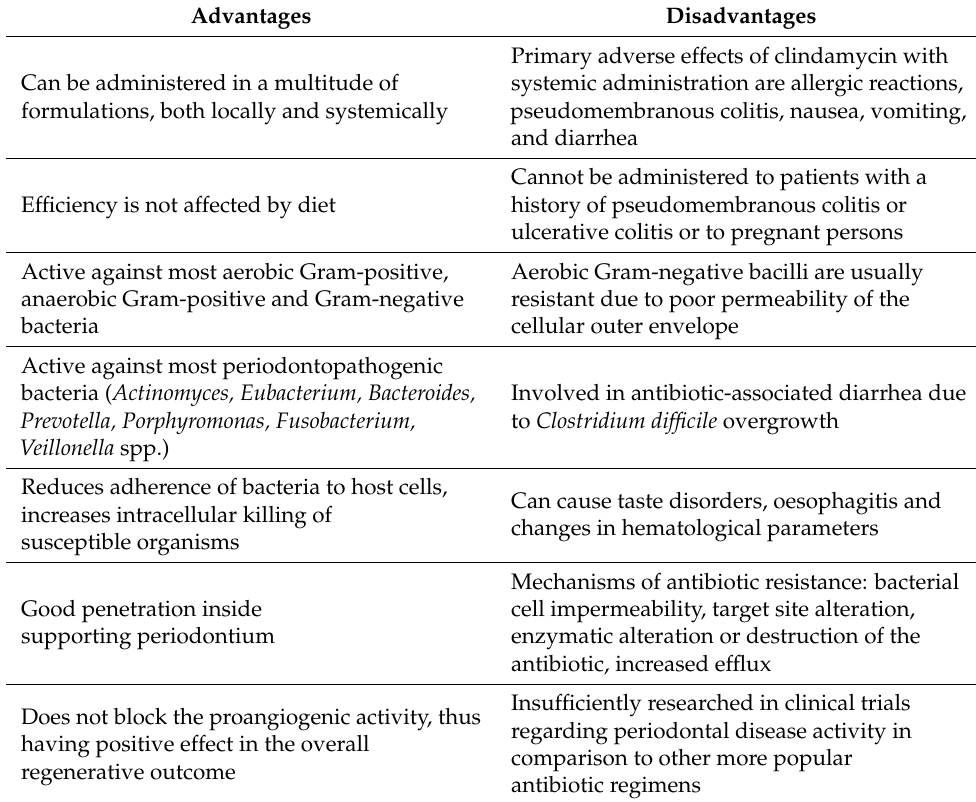
Table 1. Advantages and disadvantages of clindamycin use